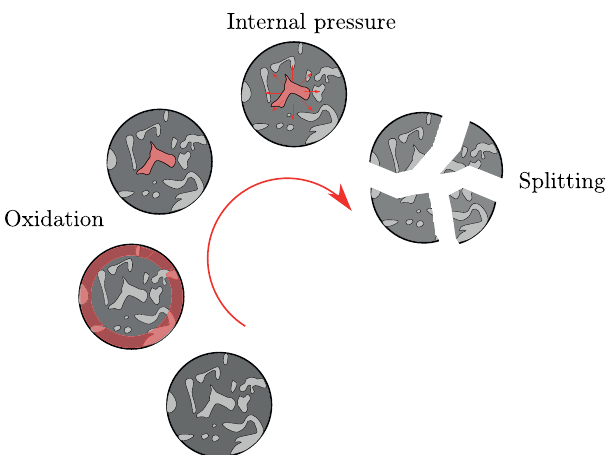
Fig. 9. Explanation of the splitting phenomenon. Dark gray, ferrite; light gray, pearlite;